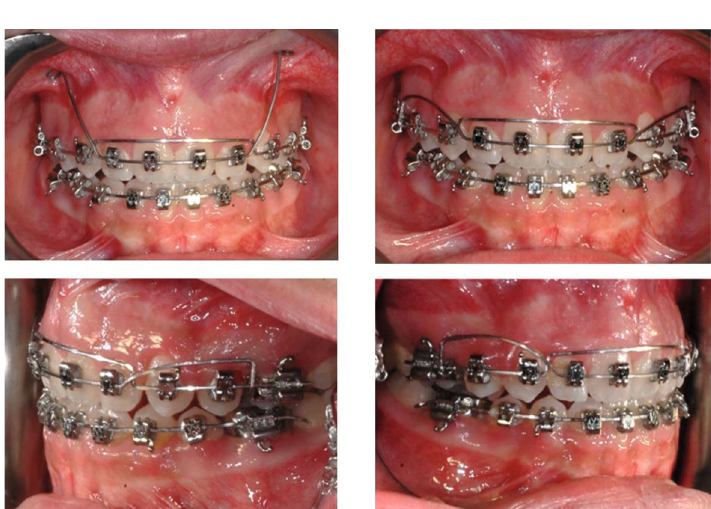
Figure 5: Second-order bend on the SS archwire with a torque